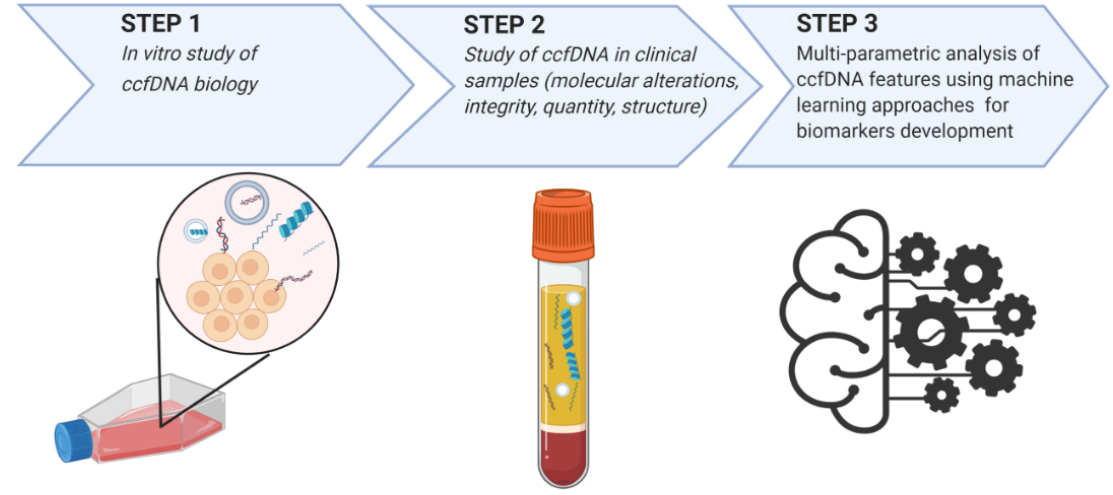
Figure 2. Research and development of ccfDNA-based biomarkers for the management of breast cancer. Abbreviations: ccfDNA = circulating cell free DNA.